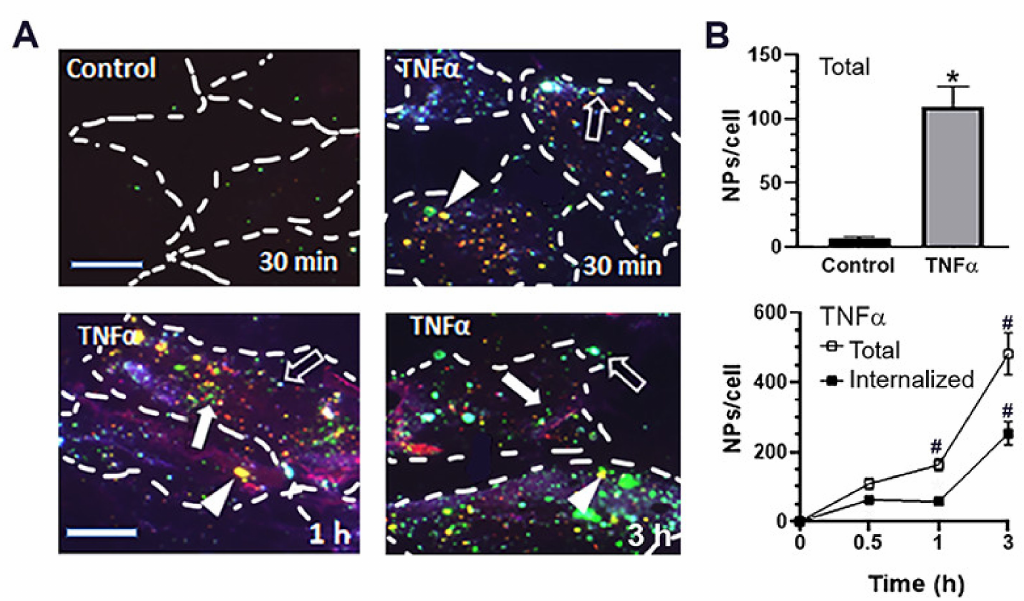
Figure 3. Cellular internalization of PLGA NPs encapsulating HAse. ( A ) Fluorescence microcopy pictures and ( B ) quantification of control vs. tumor necrosis factor α (TNF α )-activated human umbilical vein endothelial cells (HUVECs) incubated for the indicated time points with Lactel II–F68 NPs encapsulating AlexaFluor488-HAse (green) and coated with anti-ICAM. Cells were washed to remove non-bound NPs, fixed, and cell-surface NPs were stained using goat anti-mouse IgG labeled with AlexaFluor350 (blue). Cells were then permeabilized and all NPs were stained with goat anti-mouse IgG labeled with Texas Red (red). ( A ) Cell-surface NPs with anti-ICAM coat appear green + blue + red = white (open arrow), internalized NPs with anti-ICAM coat appear green + red = yellow (arrowheads), and green NPs are internalized and lack anti-ICAM coat, likely degraded in lysosomes (arrows). Dashed lines = cell borders. Scale bar = 10 µ m. ( B ) Quantification of total and internalized NPs. Data are the mean ± SEM (non-visible error bars are hidden by the data symbol). Statistics were assessed by Student’s t -test ( p < 0.05). * Compared to control; # Compared to the previous time